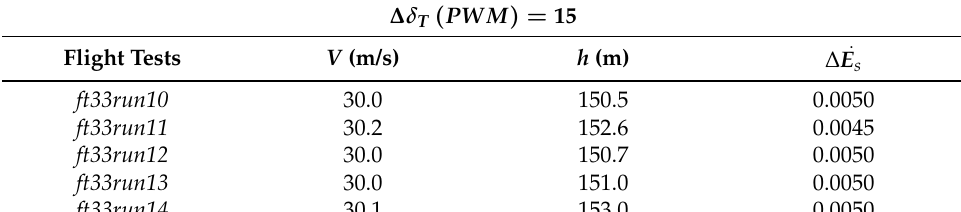
. E s from positive throttle input. PWM, Pulse Width Modulation. Table 2. The average value of ∆